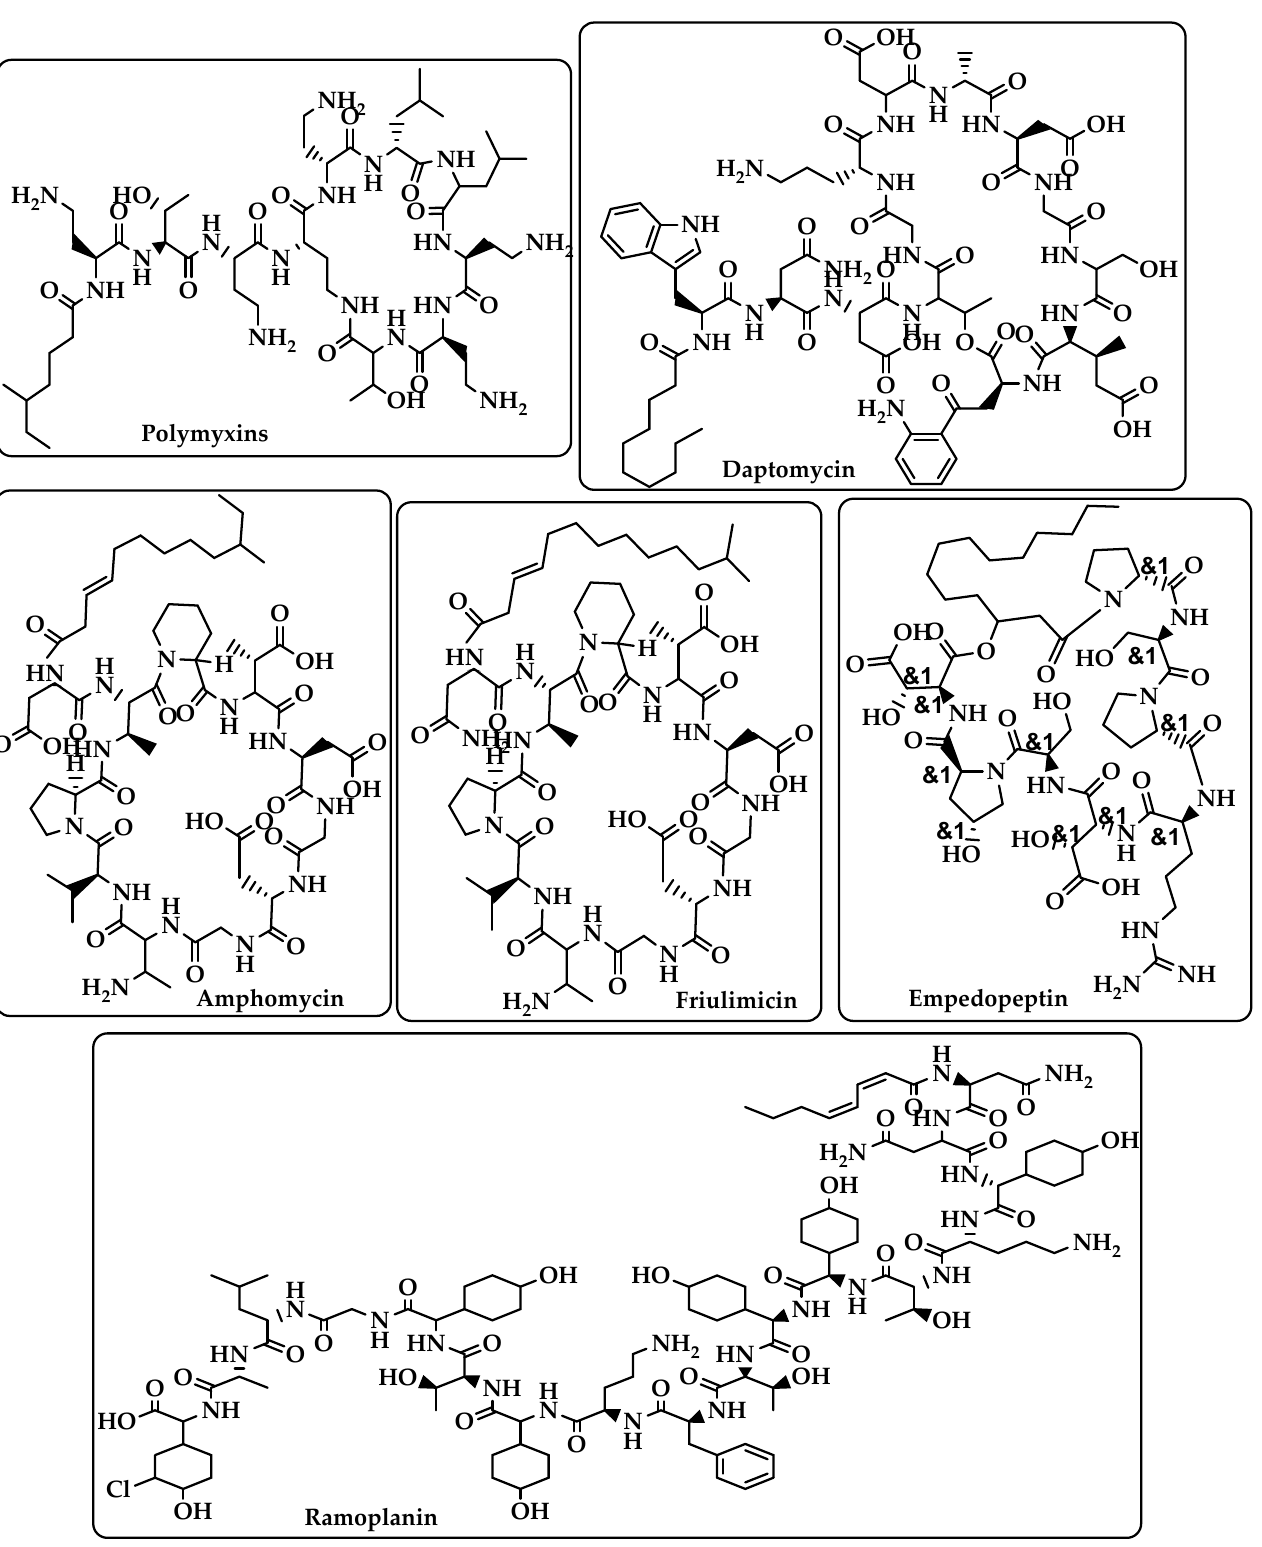
Figure 2. Chemical structure of polymyxins, daptomycin, amphomycin, friulimicin, ramoplanin, and empedopeptin.